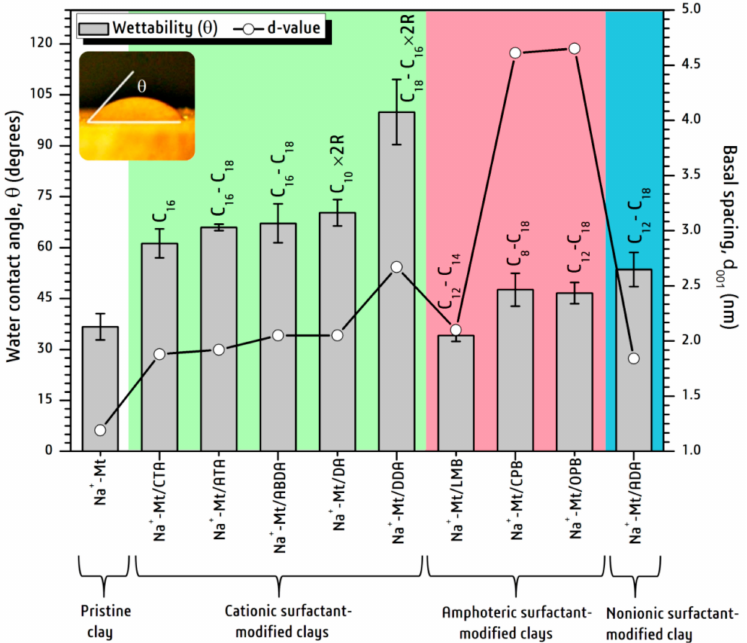
Figure 3. The relationship between organoclay types, their wettability, d-spacing and alkyl chain length (number) of surfactant. Note: R—alkyl